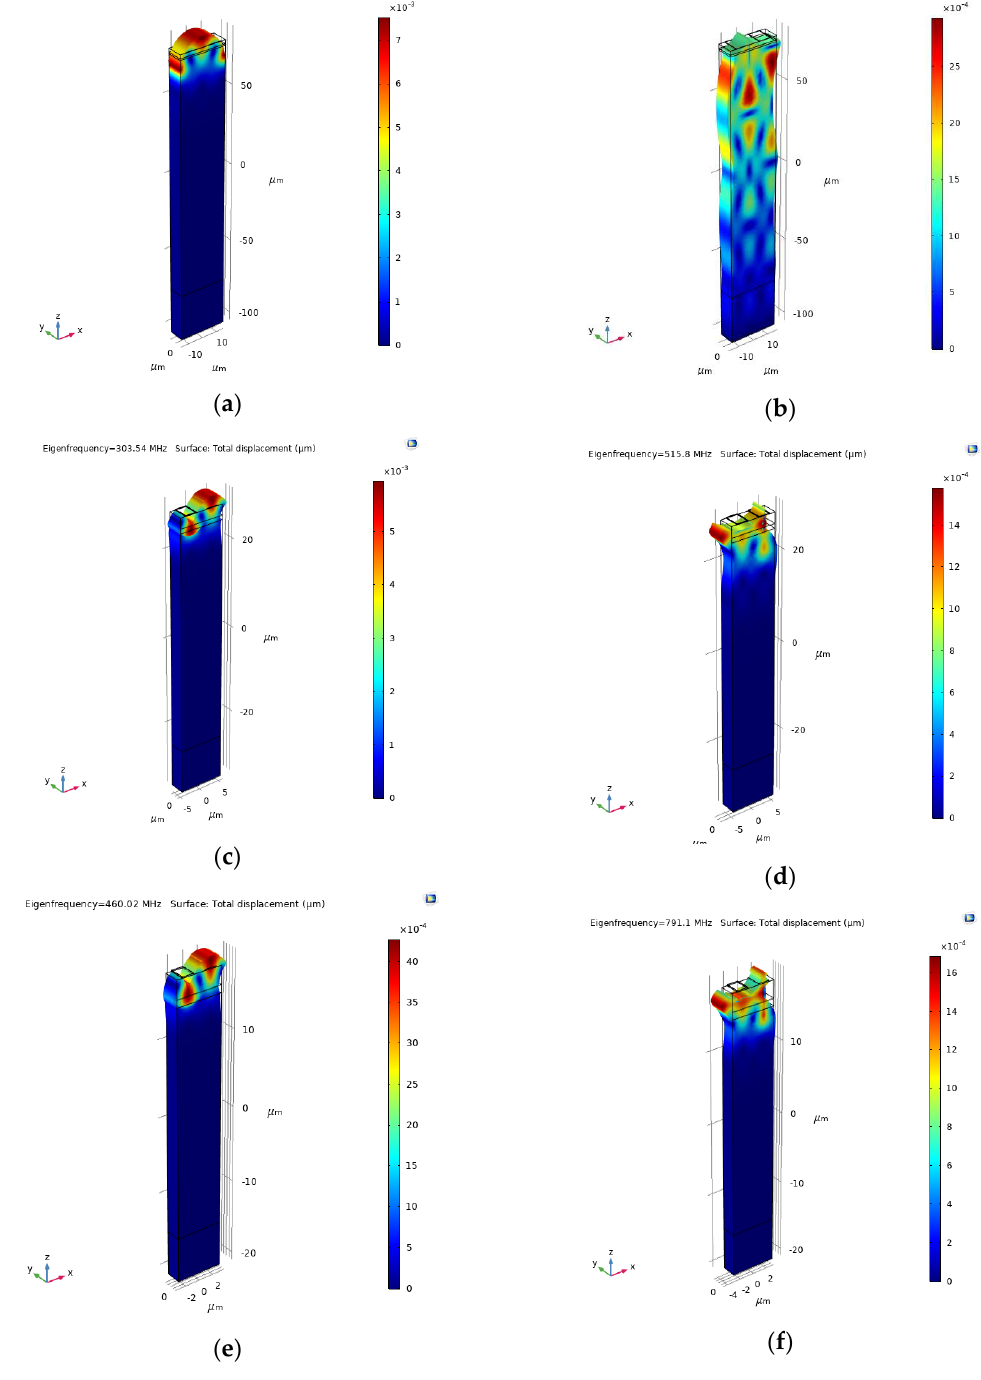
Figure 6. The solid displacement of R m and S m , for λ = 30 µ m ( a , b ); for λ = 10 µ m ( c , d ); and for λ = 6 µ m ( e , f ).